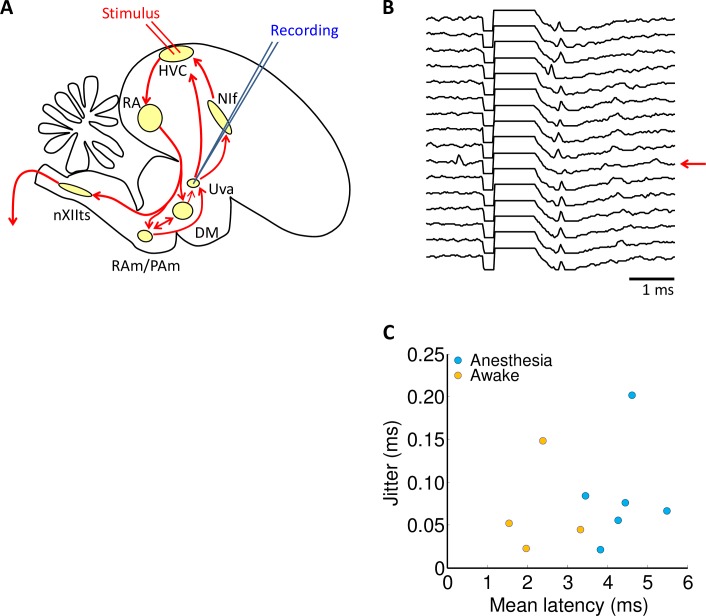
Multi-unit recordings in Uva during singing.(A) Simplified schematic view of the oscine song control system. Multiunit recordings were made in HVC-projecting core of Uva, which was antidromically identified by electrical stimulation in HVC. (B) Antidromic activation of neurons in Uva. Traces shows the response in Uva across sequential stimulations. Red arrow indicates a trial during which a spontaneous spike occurred, preventing in antidromic response in Uva. (C) Latency and jitter of antidromic responses in awake and anesthetized birds.